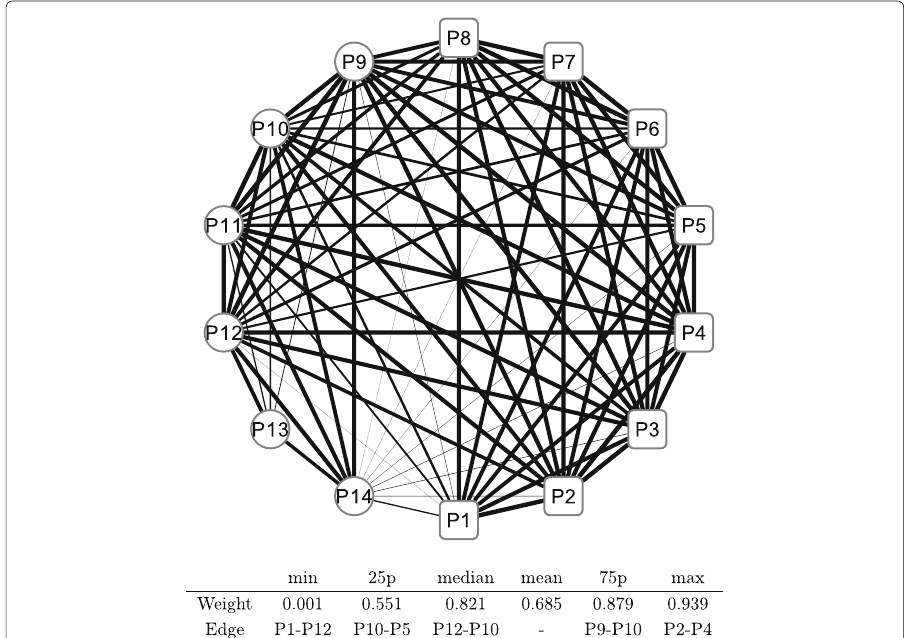
Fig. 9 Correlation network of sub-portfolios: sub-period T1. Note: The network is created based on the network adjacency matrix of the sub-period category T1. For further details, see the note of Fig. 8